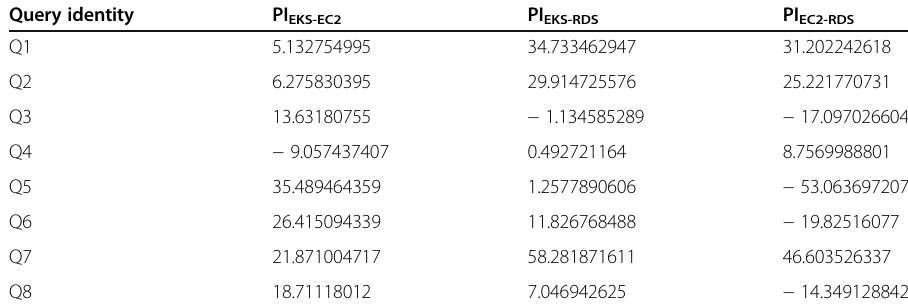
Table 16 Comparing percentage improvement (PI AB ) in AET Query identity PI EKS-EC2 PI EKS-RDS PI EC2-RDS